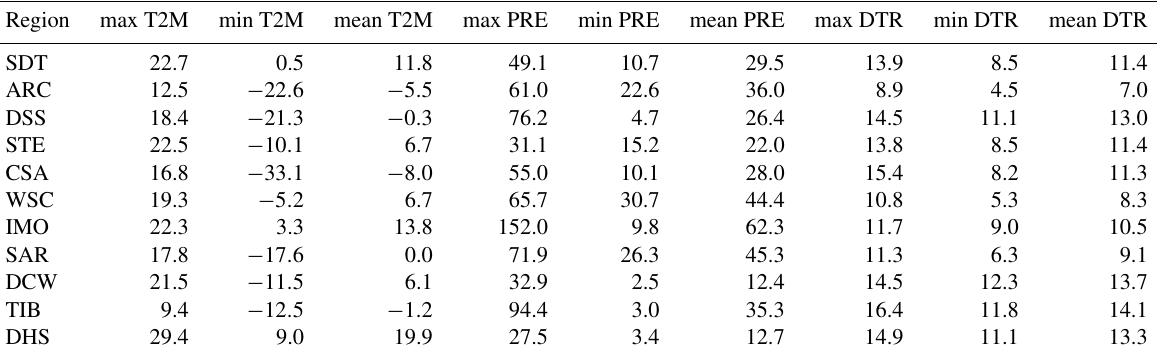
Table 3. Subregions resulting from the k -means clustering based on climatological monthly means of near-surface temperature (T2M, CRU), precipitation (PRE, GPCC) and diurnal temperature range (DTR, CRU) for CORDEX Central Asia. Abbreviations are assigned to the different regions corresponding to their main climatic characteristics. Together with the names, mean climatic information is provided for each area. The regions illustrate the wide range of climate zones of the Central Asia